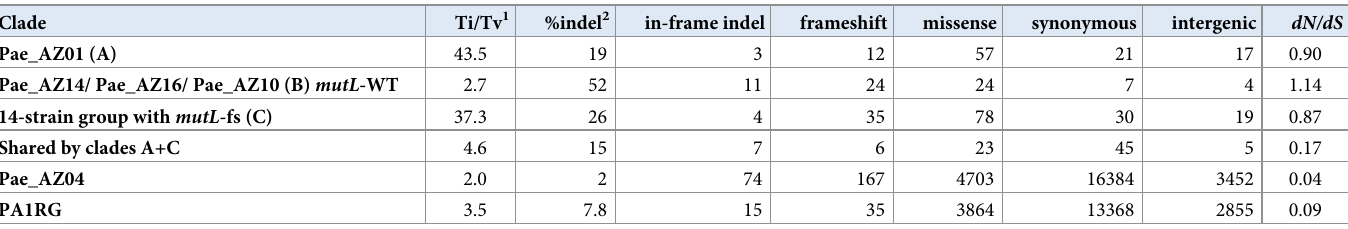
Table 2. Evolutionary parameters of P . aeruginosa genomes.